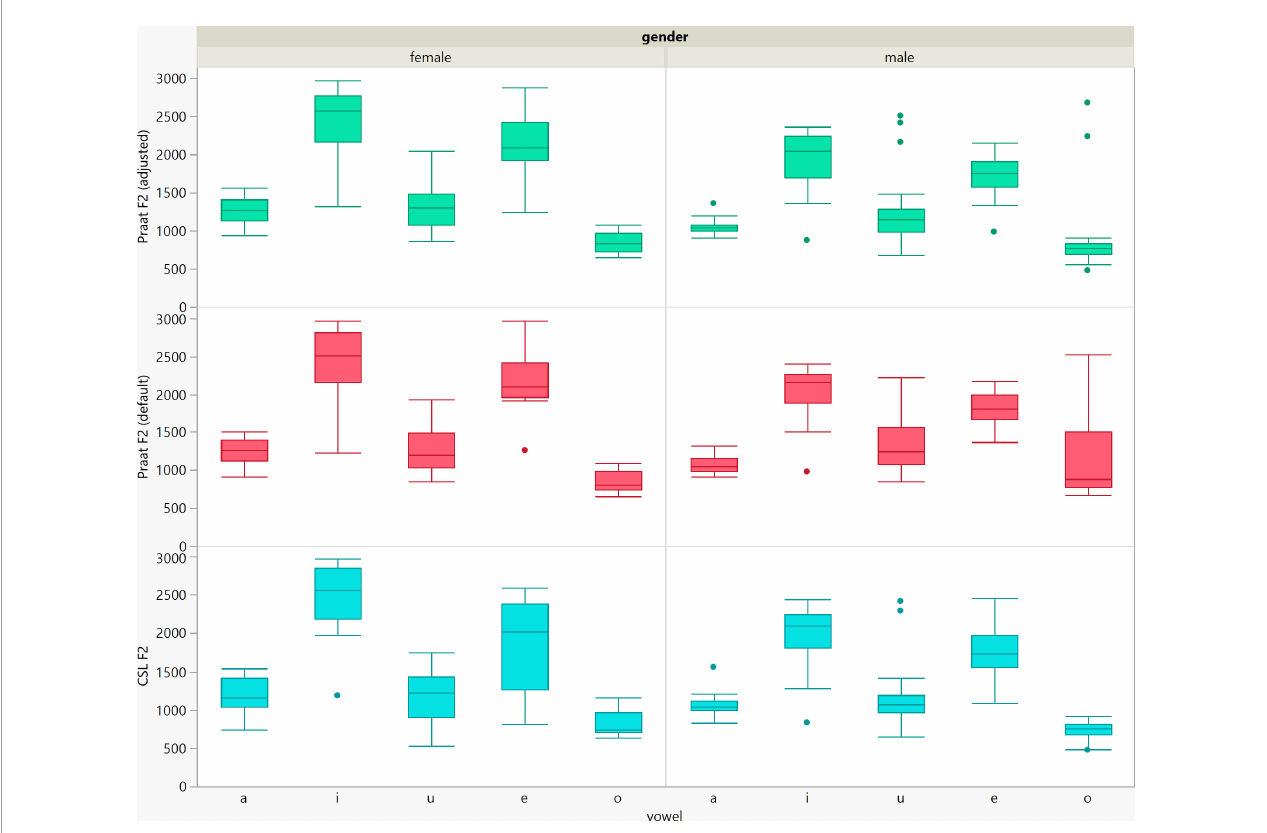
FIGURE6 Box plots of the F2 data of the five vowels calculated using Computerized Speech Lab (CSL) and Praat with the default and adjusted settings for both men and women.